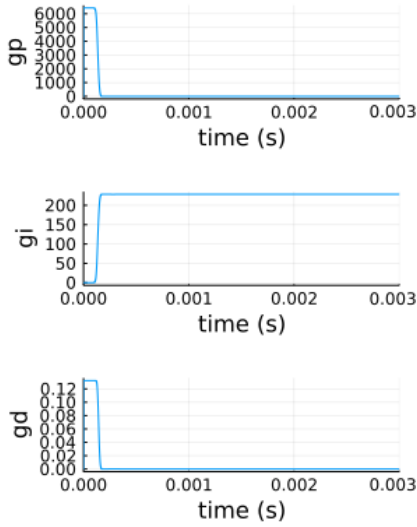
Figure 10. Variation of the adaptive gains of the controller (obtained by WOA optimization) during the initial transition.